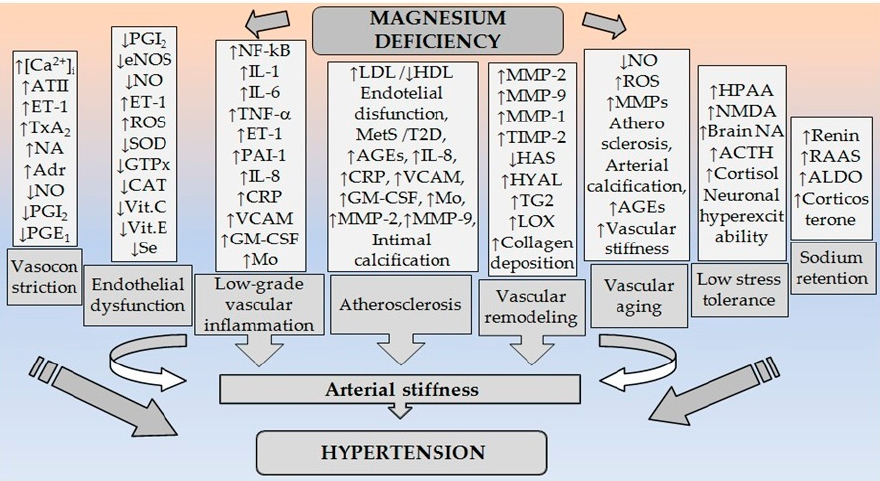
Figure 1. Pathogenetic relationships between MgD and arterial hypertension. (Abbreviations: ↑ : increased; ↓ : decreased; [Ca 2+ ] i : intracellular calcium in VSMCs; ATII: angiotensin II; ET-1: endothelin-1; TxA 2 : thromboxane A 2 ; NO: nitric oxide; PGE 1 : prostaglandin E 1 ; PGI 2 : prostaglandin I 2 ; ROS: reactive oxygen species; NF-kB: nuclear factor kappa B; TNF- : tumor necrosis factor- α ; IL-1: interleukin-1; IL-6: interleukin-1; IL-8: interleukin-8; PAI-1: plasminogen activator inhibitor-1; VCAM: vascular cell adhesion molecule-1; GM-CSF: granulocyte-macrophage colony-stimulating factor; Mo: monocytes; CRP: C-reactive protein; SOD: superoxide dismutase; GTPx: glutathione peroxidase; CAT: catalase; Vit.C: vitamin C; Vit.E: vitamin E; Se: selenium; LDL: low-density lipoproteins; HDL: high-density lipoproteins; MetS: metabolic syndrome; T2D: type 2 diabetes; AGEs: advanced glycation end products; MMPs: matrix metalloproteinases; MMP-1: matrix metalloproteinase-1; MMP-2: matrix metalloproteinase-2; MMP-9: matrix metalloproteinase-9; TIMP-2: tissue inhibitor of metalloprotease-2; HAS: hyaluronan synthases; HYAL: hyaluronidase; TG2: transglutaminase; LOX: lysyl oxidase; HPAA: hypothalamic pituitary adrenal axis; NMDA: